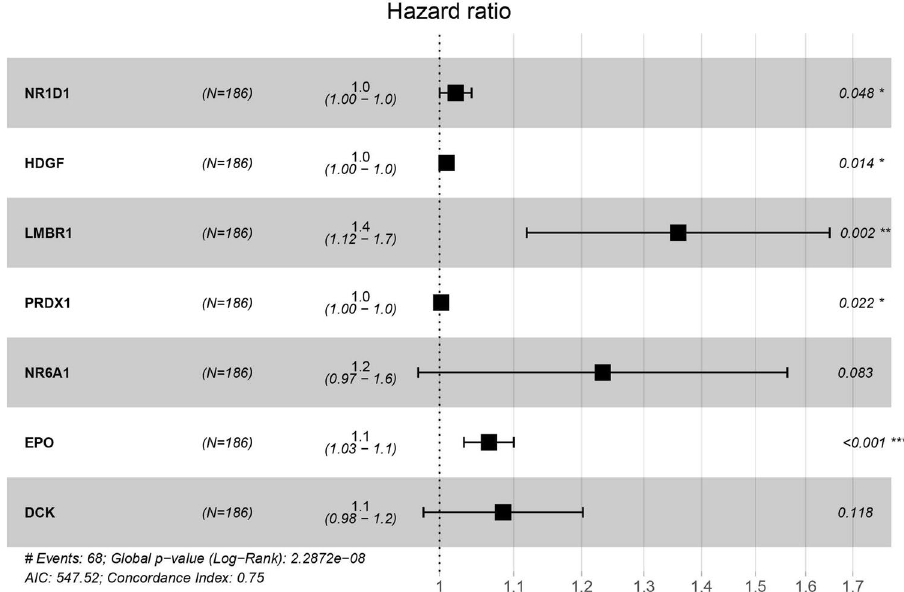
Figure 4. The IRGs in prognostic signature identified by multivariate Cox